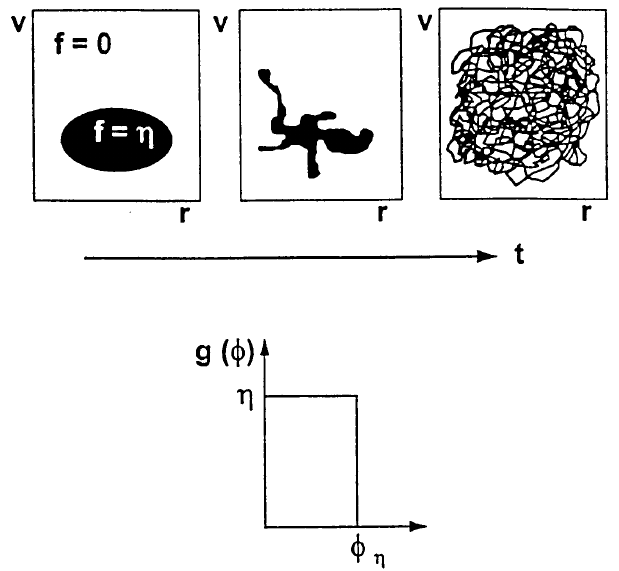
Fig. 5. Sketch of a simple distribution function with some value g in some domain in phase space of total volume / space ( upper row ) together with the corresponding reduced distribution function describing phase-space density conservation in the framework of the exact